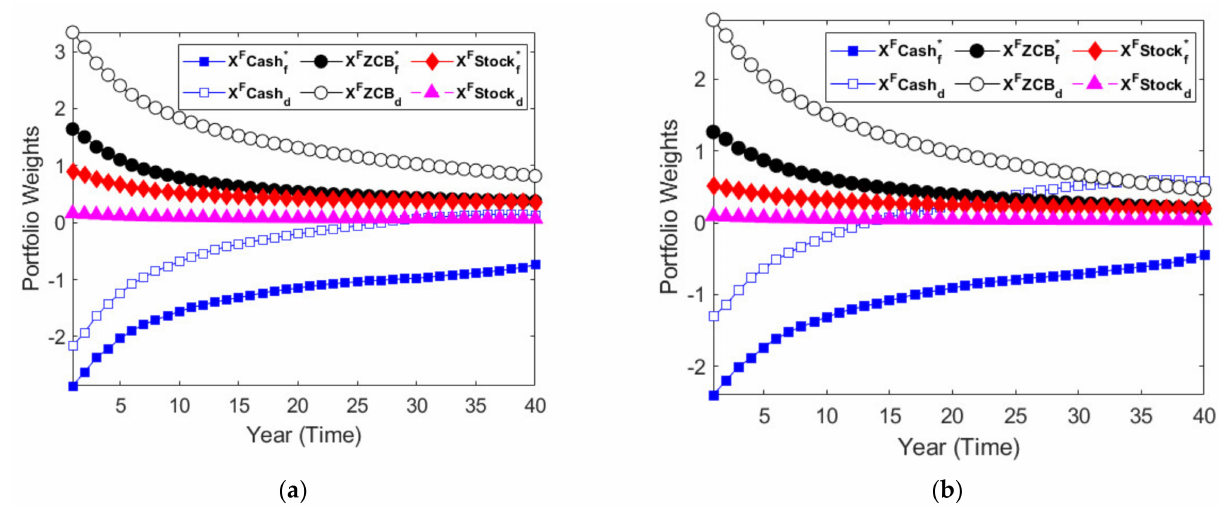
Figure 1. Optimal proportions of pension portfolio assets. Notes: The two subfigures depict the optimal allocation weights of the pension fund portfolio ( F ) in domestic and foreign assets with regard to the minimum guarantee (g) under the exchange rate risk ( σ X ). The notations X F Cash d , X F ZCB d , and X F Stock d are the fund’s allocative weights in domestic assets, including cash, zero-coupon bonds (ZCBs), and stocks, while X F Cash ∗ , X F ZCB ∗ , and X F Stock ∗ are those of the fund’s foreign assets. The f f f risk-aversion coefficient is γ . The parameters in Table 1 are applied for the numerical experiments with ( a ) g = 10; γ = − 3, σ X = 0.1; ( b ) g = 10; γ = − 6, σ X =